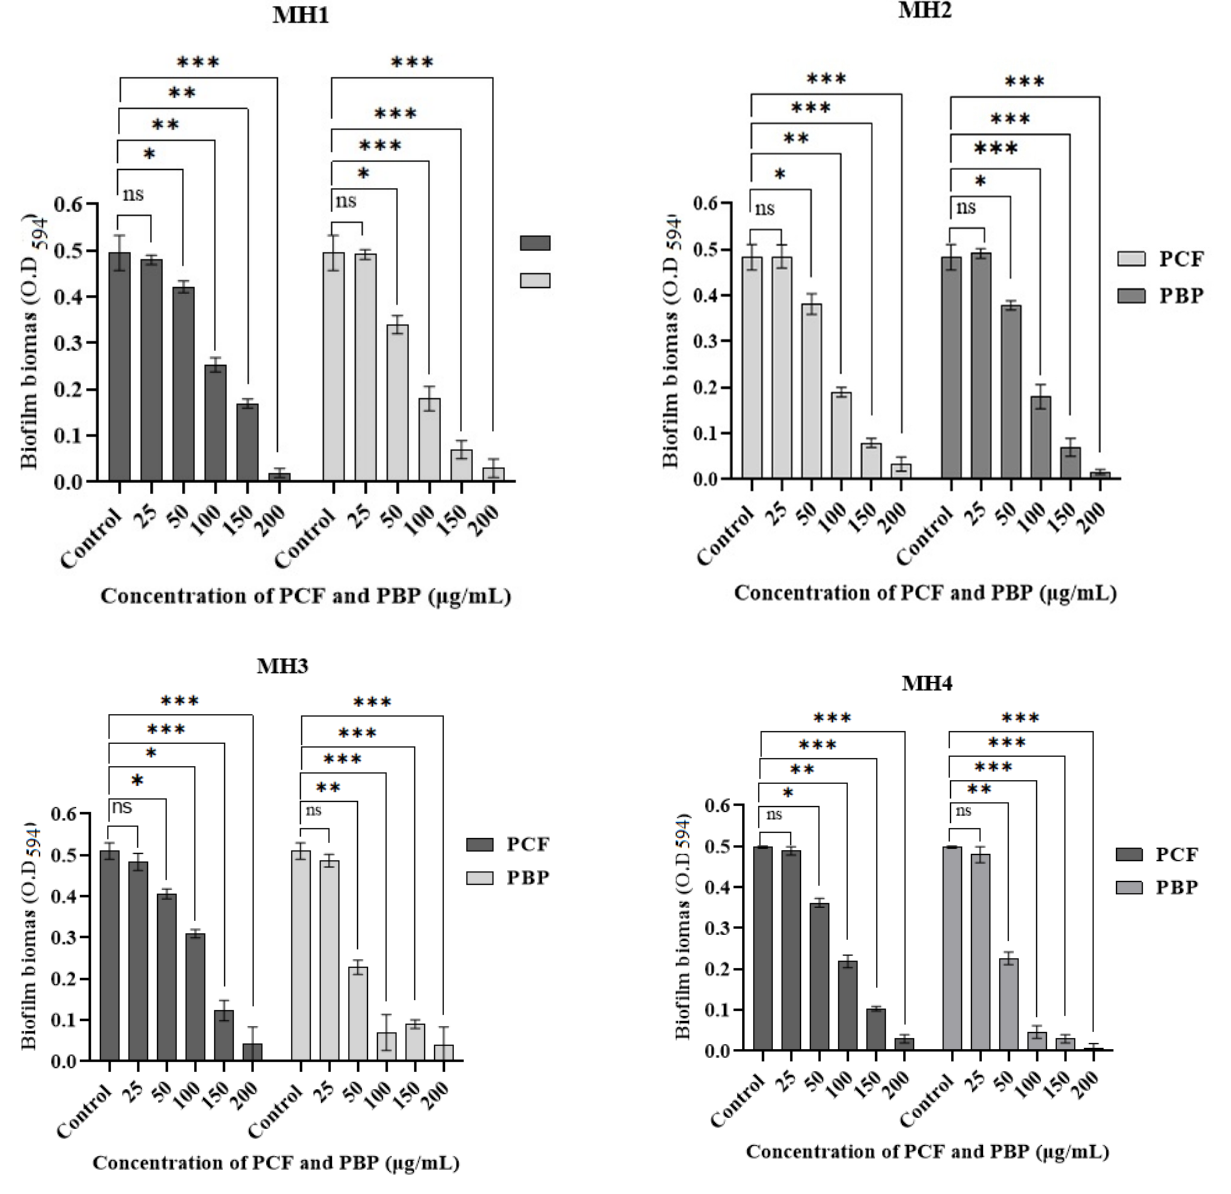
Figure 2. The antibiofilm potential of PBP and PCF at 25, 50, 100, 150, and 200 µ g/mL concentrations against MH1 ( P. aeruginosa MT448672), MH2 ( E. coli MT448673), MH3 ( S. aureus MT448675), and MH4 ( K. pneumoniae MT448676) bacterial strain cultures. Graphs were prepared on Prism